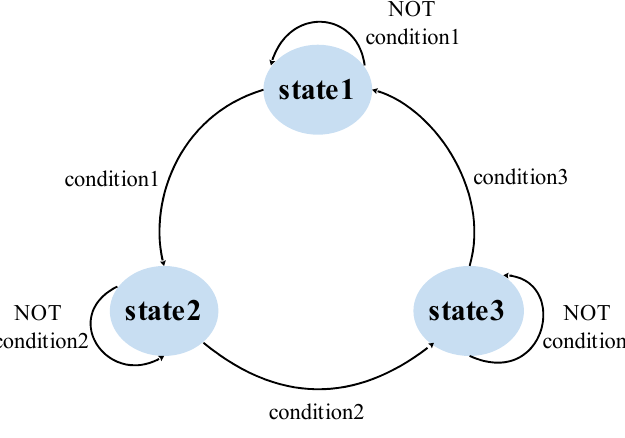
Figure 5 . State transition diagram. Figure 5. State transition